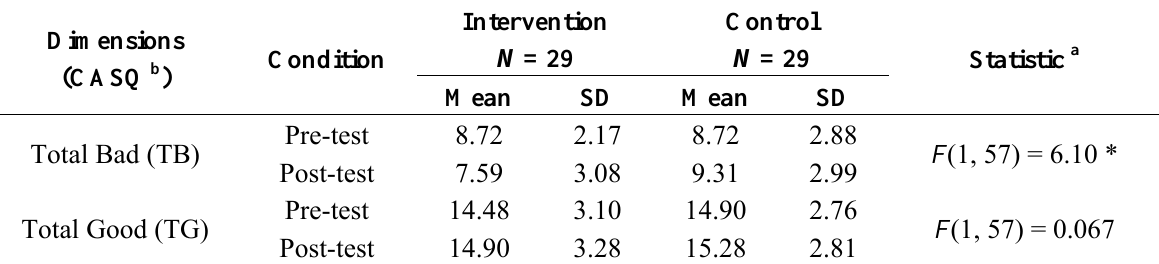
Table 2. Differences across intervention and control groups on dimensions of the CASQ. Dimensions